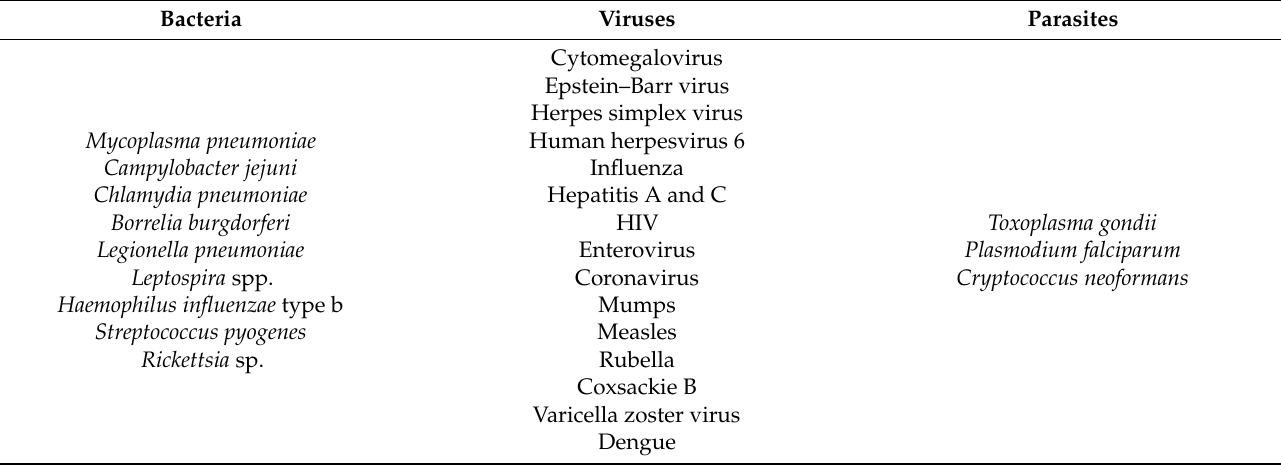
Table 1. Main infectious agents involved in acute disseminated encephalomyelitis (ADEM). Bacteria Viruses